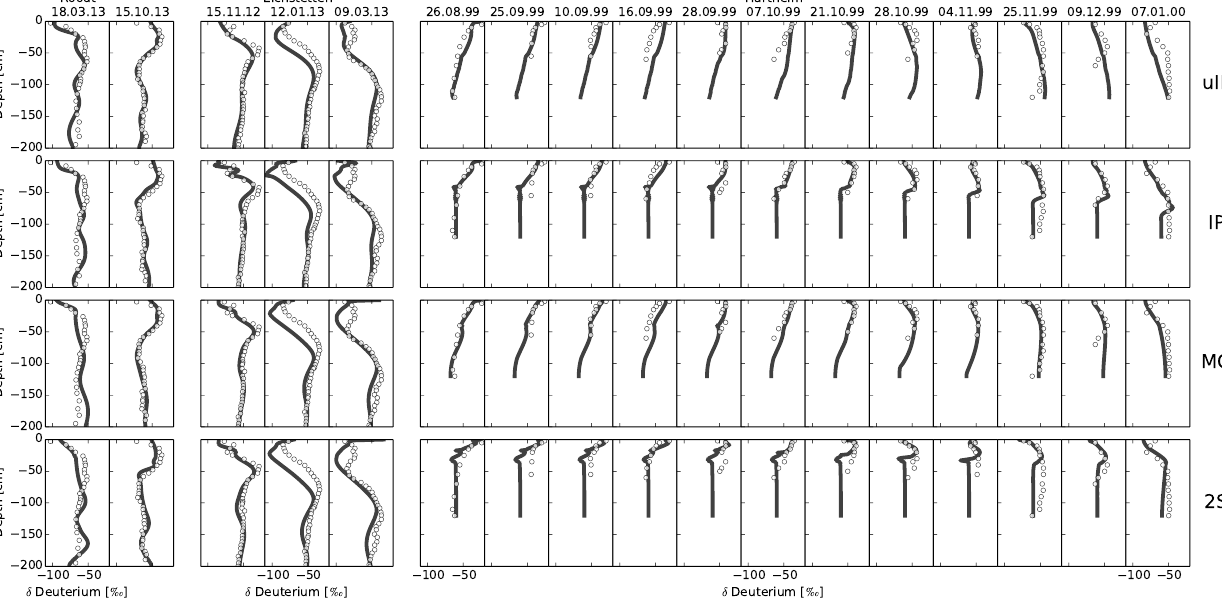
(at Hartheim there were no soil moisture measurements in the lower layer). For Hartheim, the high variation of the